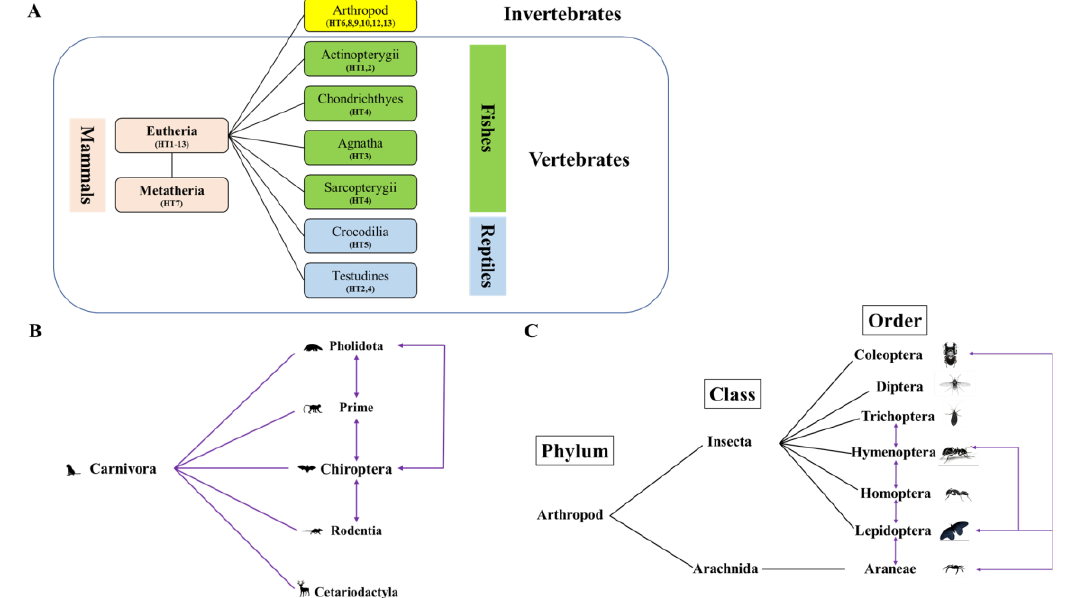
Figure 7. ( A ) The presented distribution and HT events of Tigger in eukaryotes; each black line represents HT events we detected, while the numbers represent the incidence of HT events of Tigger ; ( B ) the HT events of Tigger within Eutheria; each purple line represents HT events we detected; ( C ) HT events of Tigger within arthropods. The black line represents Arthropod taxonomic classification; however, each purple line represents HT events we detected.